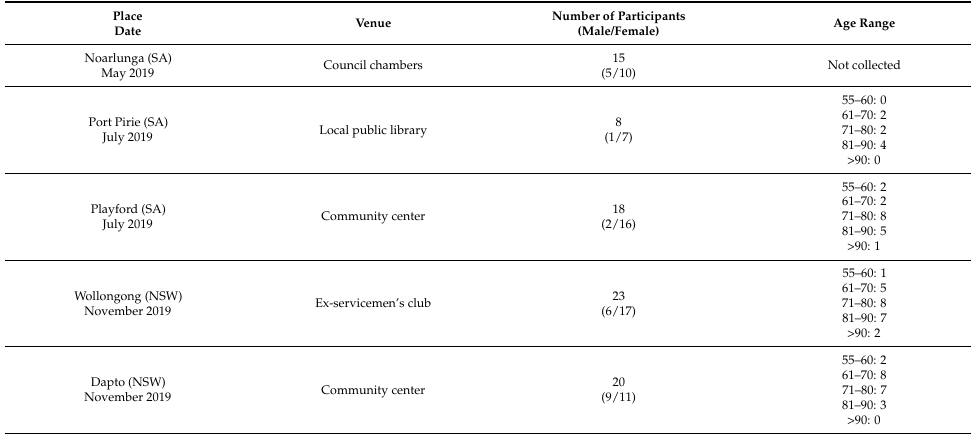
Table 1. Description of World Caf é s and